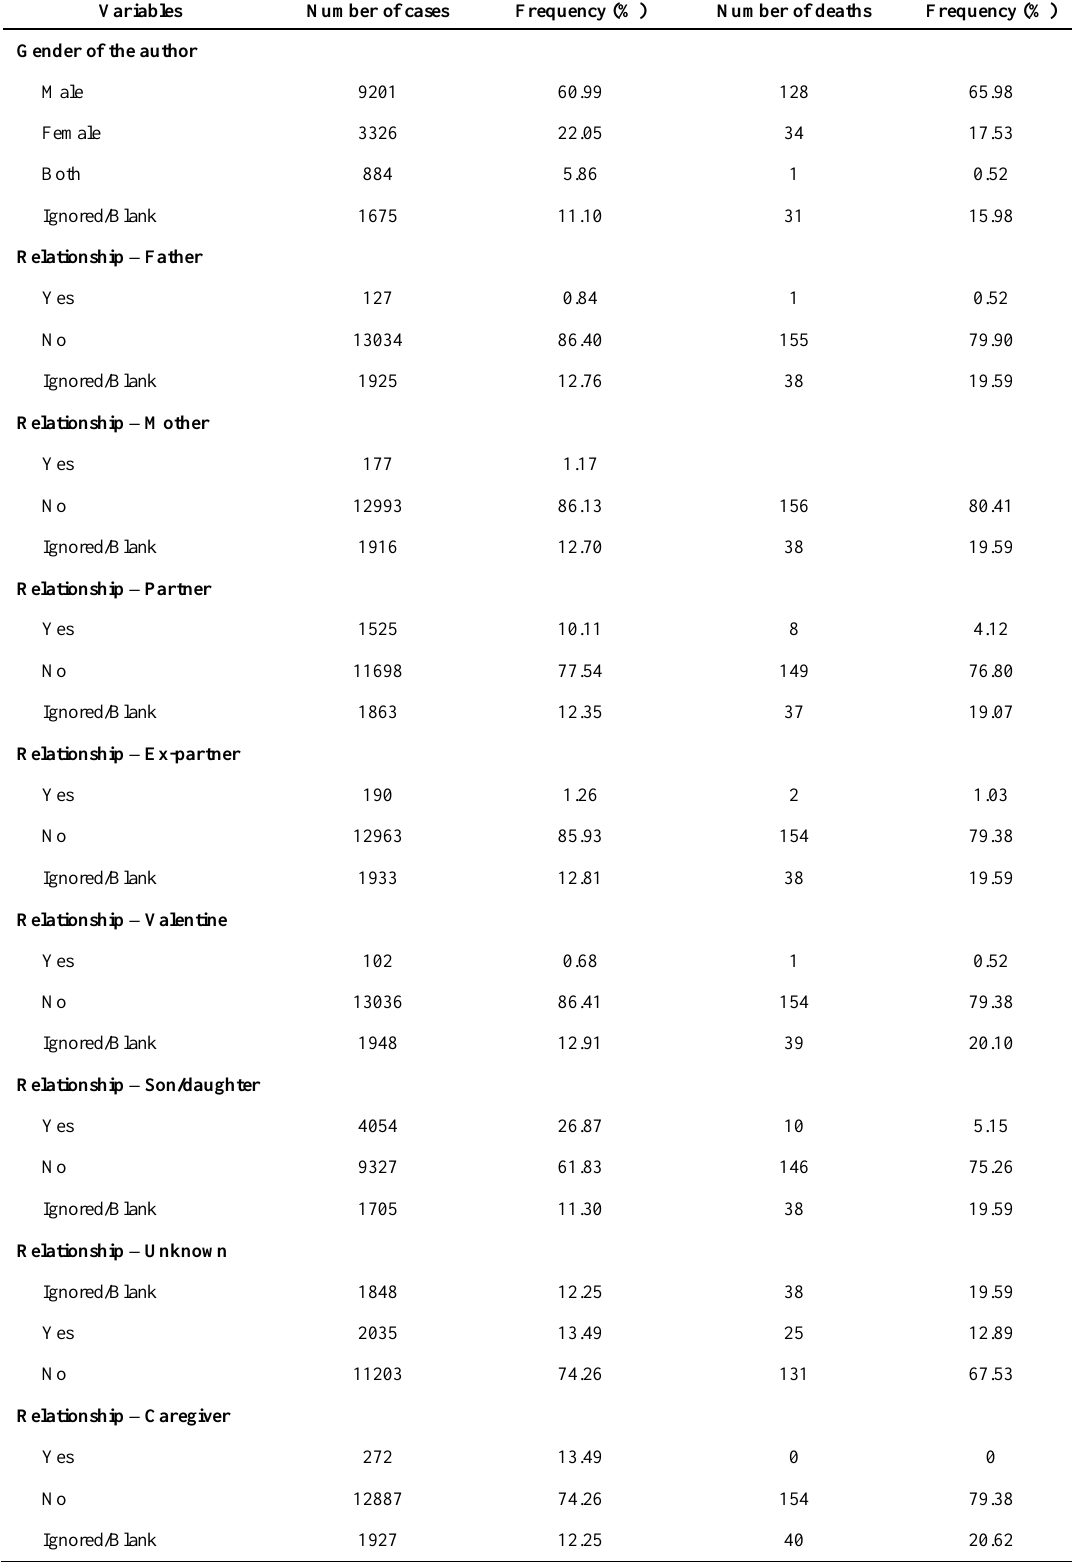
Table 3. Distribution of violence against the elderly cases according to sex and relationship of the author. Data from SINAN between 2007 and 2017 Variables Number of cases Frequency (%) Number of deaths Frequency (%) Gender of the